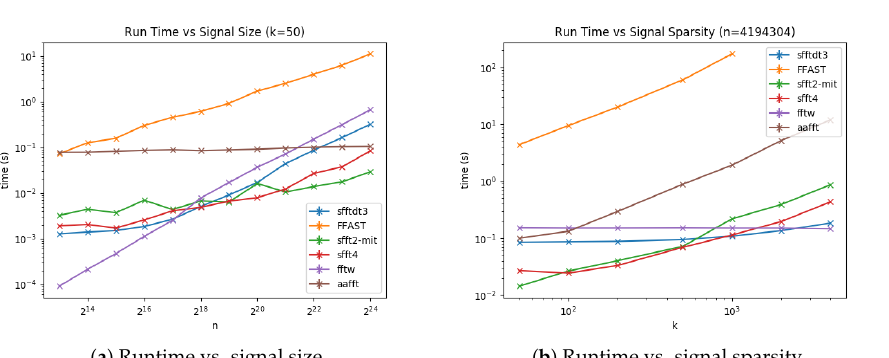
Figure 10. Runtime of two typical algorithms using the aliasing filter and four other algorithms, including the sFFT-DT3.0, R-FFAST, sFFT2.0, sFFT4.0, fftw, and AAFFT0.9 algorithms in the general sparse